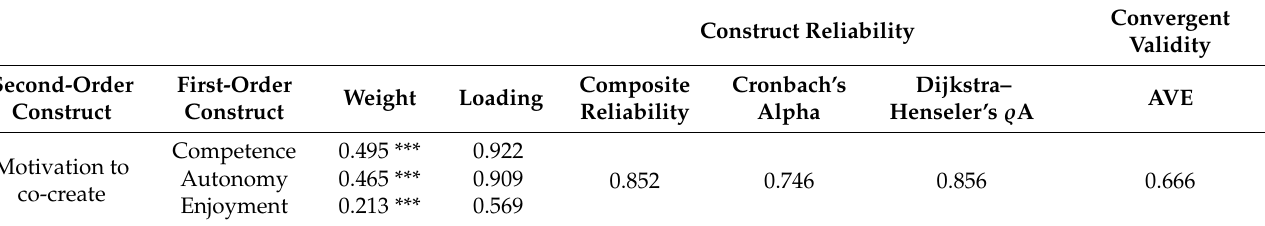
Table 5. Motivation to co-create. Measurement